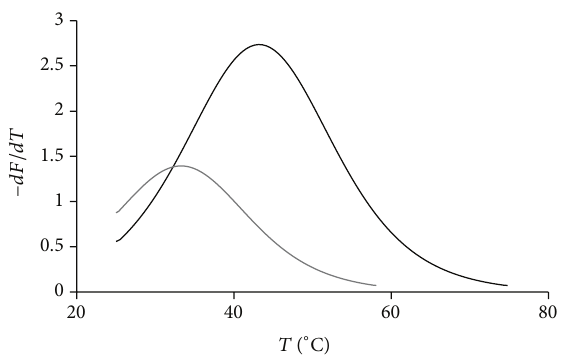
Differential melting curves of duplexes (IVb+IIb) ⋅ mmDNA (gray) and (IVb+IIb) ⋅ fcDNA (black) obtained upon excimer fluorescence detection. Melting curves were recorded with 2 ⋅ 10 −7 M solutions of duplexes in 6.7 mM Tris-HCl (pH 8.9), 16mM (NH 4 ) 2 SO 4 , and 3.6 mM MgCl 2 . Fluorescence values were registered at 480 nm at an excitation wavelength of 345 nm upon heating of samples at a rate of 0.7–1.5 ∘